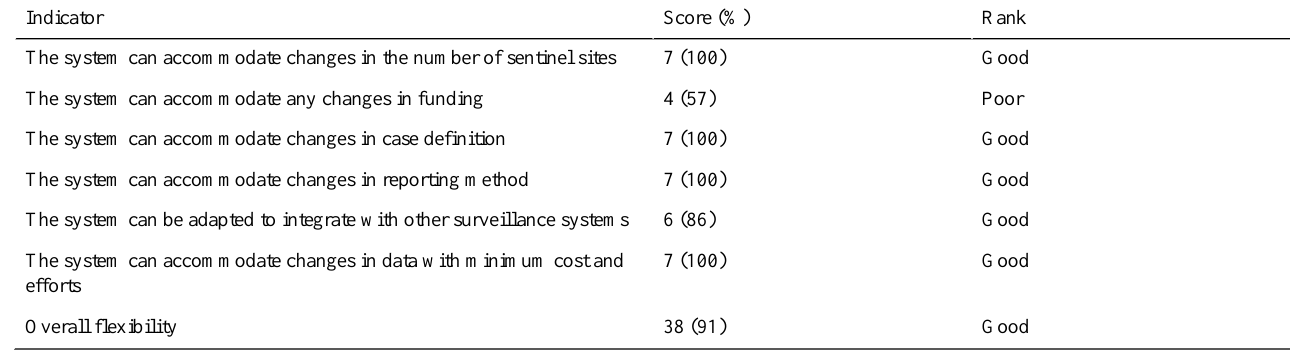
Table 2. The scores (score percent, %) and rank of the flexibility indicators as assessed by the central-level stakeholders.